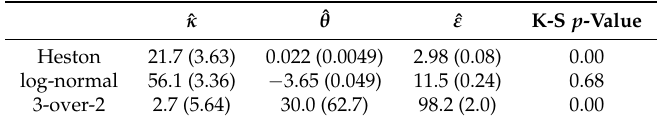
Table 3. S&P 500: Estimated parameters and standard errors from (approximate) maximum likelihood estimation of the Heston, log-normal, and 3-over-2 models.